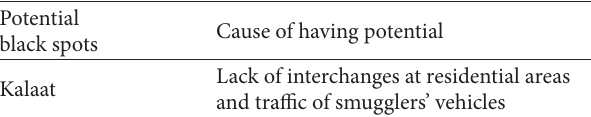
Table 2: Section 2: Polchamani-Kalaat.